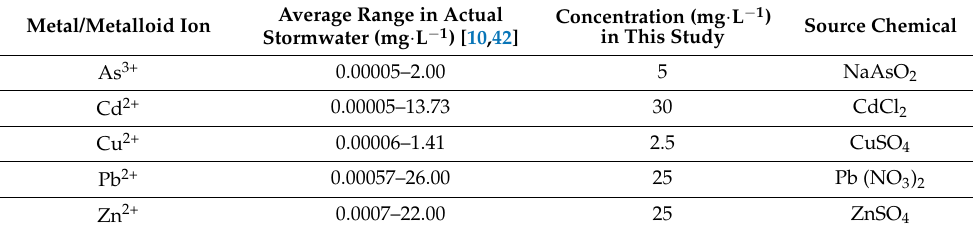
Table 2. Metal concentrations in actual stormwater, concentrations considered in this study, and the source chemicals used in the preparation of the stormwater